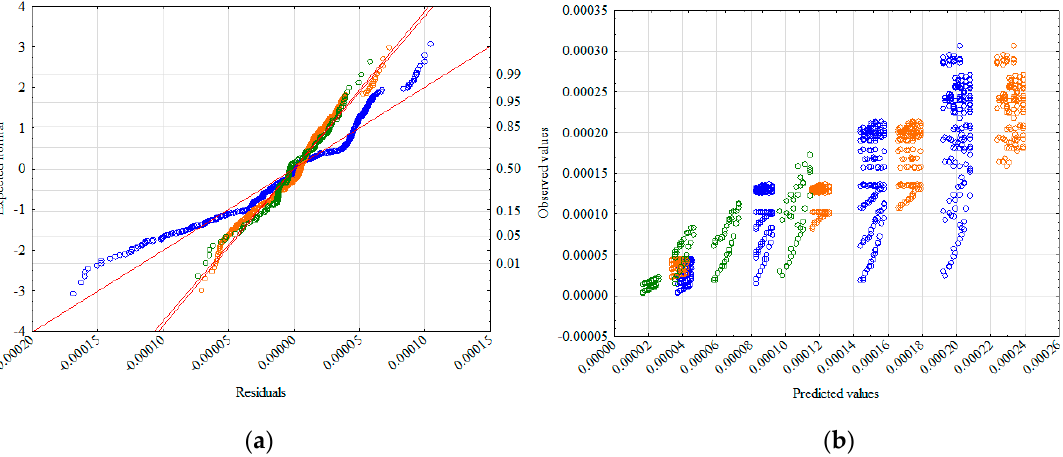
Figure 9. Normality diagram of residuals (model 1—blue color, model 2—red color, and model 3—green color) ( a ) and values observed against predictions (model 1—blue color, model 2—green color, and model 3—orange color) ( b ).